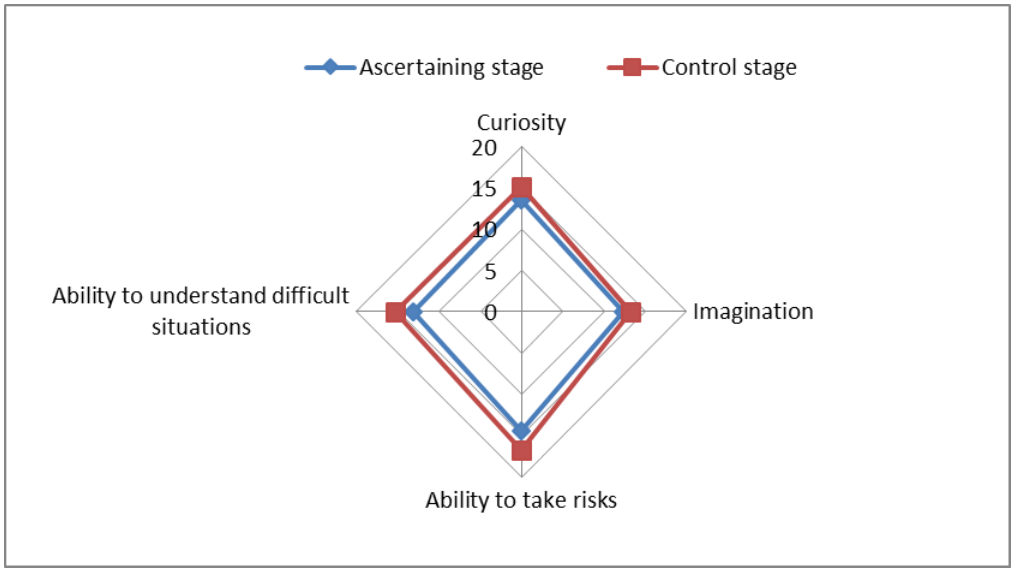
Figure 2. Creativity indicators average values at the ascertaining and control stages of research Comparison of data obtained at the ascertaining and control stages of the study allows to establish that the average of creativity overall level and individual indicators has become higher. Certain individual indicators of creativity increased by 2.3 (the "Ability to understand difficult situations" indicator). The increase in the level of creativity and its indicators were confirmed at a statistically significant level (it was measured by Wilcoxon T-test). Significant differences (p ≤ 0.01) were identified in creativity overall level and individual